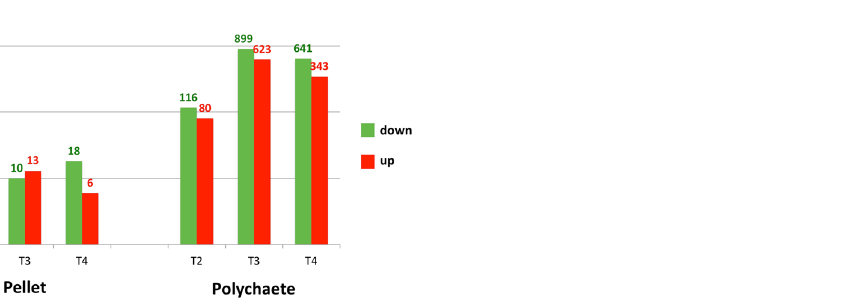
Figure 2. Venn diagram of DEGs of the pellet-fed shrimp and the polychaete-fed shrimp ( A ) after the 4-week feeding trial and before eyestalk ablation (T1) and ( B ) after eyestalk ablation at Day 1, 4, and 9 (T2, T3, and T4, respectively).